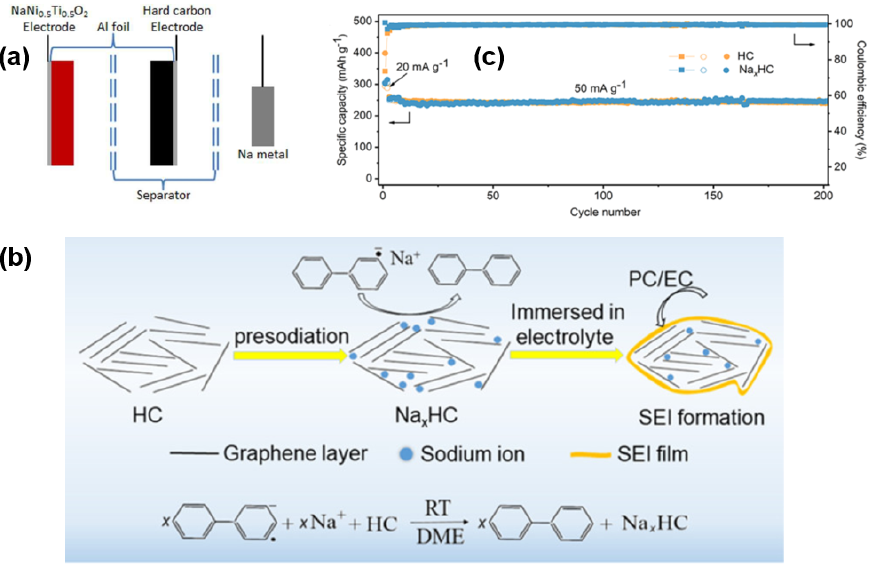
Figure 18. ( a ) Schematic illustration of three-electrode SIB, which use Na foil as the reference elec- trode [134]. ( b ) Schematic diagram of chemical pre-sodiation progress. ( c ) Cycling stability of HC and Na x HC electrodes at 0.05A g −1 [135].